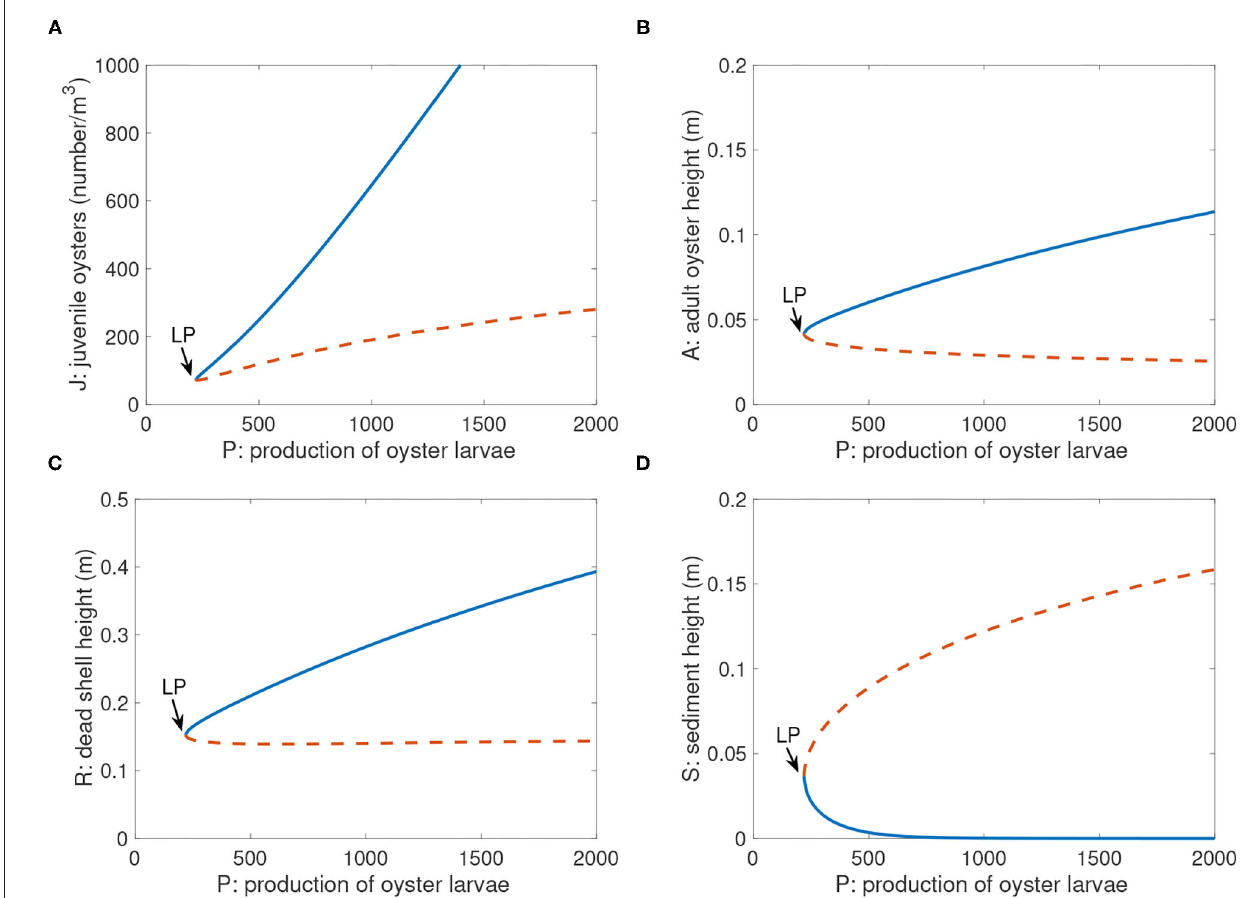
FIGURE 6 | Bifurcation diagram of positive equilibria of Equations (1) and (4)-(6) with parameter P . Not shown is the extinction equilibrium line for J , A , and R , which is at the abscissa for all values of P . Parameter values are in Table 2 . (A) : J ; (B) : A ; (C) : R ; (D) : S . The point labeled “LP” is the saddle-node bifurcation point P critical = 220.6. Blue solid branch: stable; orange dashed branch: unstable. The bifurcation diagram was generated by Matlab package Matcont .